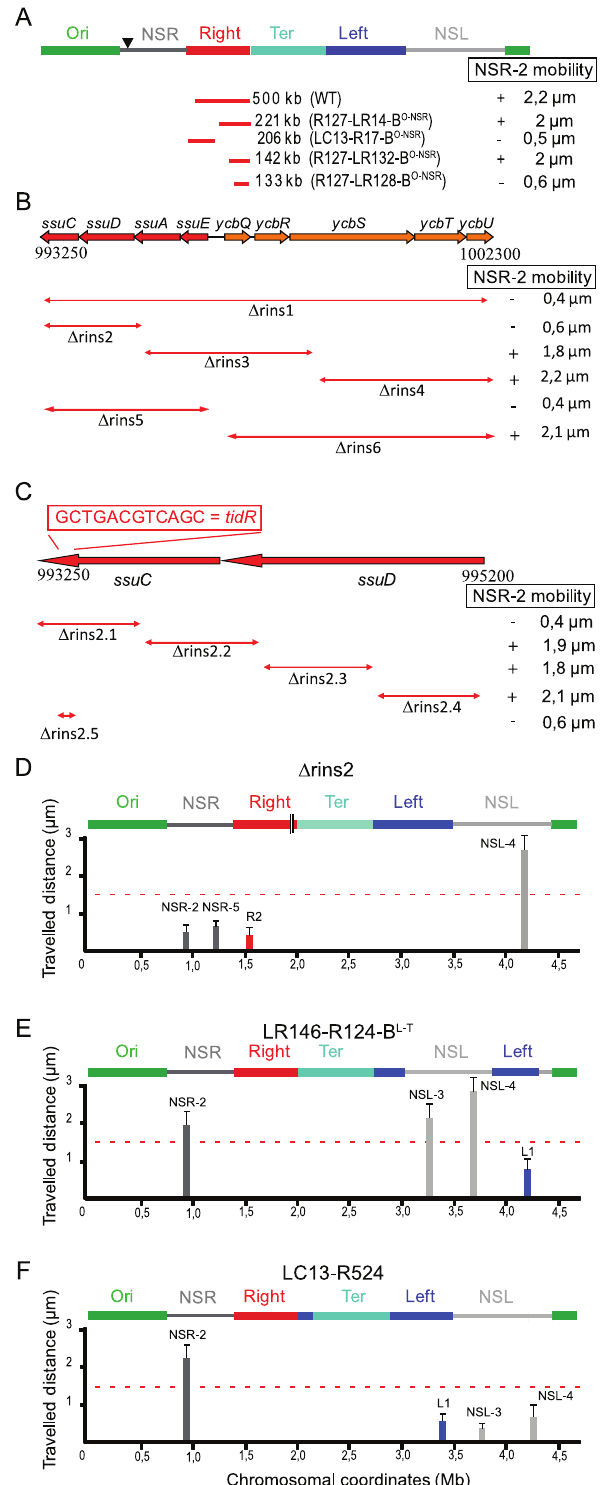
Figure 3. Identification of insulation determinants tid R and tid L. (A) Transposition of different fragments of Right MD between the Ori MD and the NS Right region (indicated by an arrowhead). The remaining part of the Right MD separating the NS Right region from the Ter MD is indicated by the red lines. The size of the remaining part is indicated in kb beside the name of the strain. Mobility of the marker NSR-2 is given and the presence of the insulation determinants is indicated by ‘‘ + ’’.